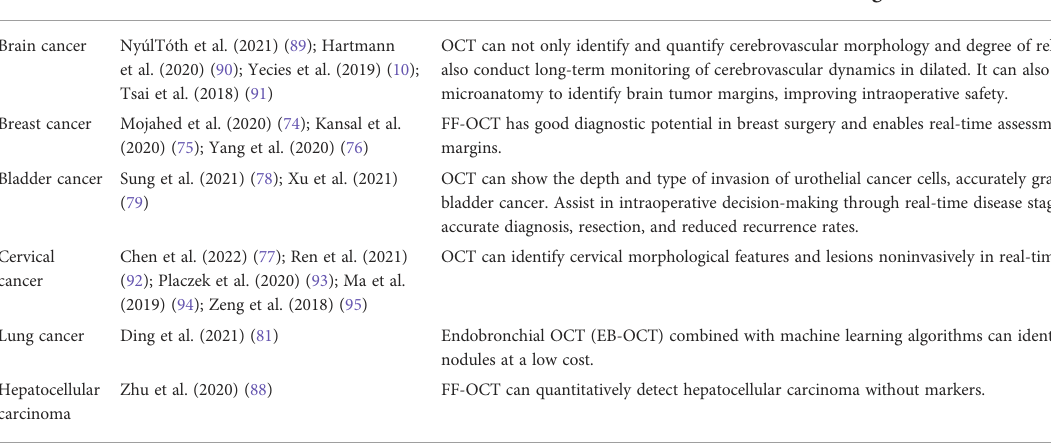
TABLE 3 The imaging capabilities of OCT in deep tumors. Cancer Authors Brain cancer